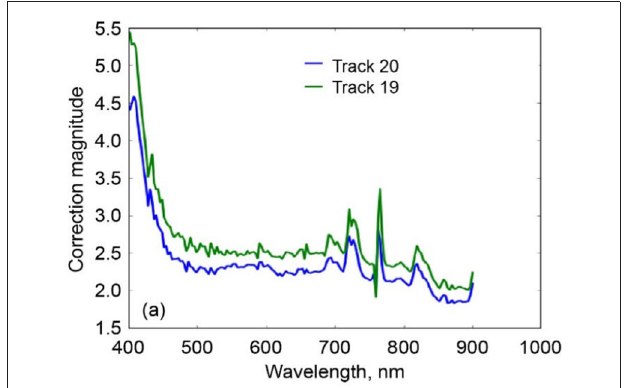
FIGURE 5 | Wavelength-specific correction coefficients derived from comparing to in situ reflectance for two NASA Glenn, second generation Hyperspectral imager (HSI2) tracks (track 19 and 20) (After Figures 4.5, Lekki et al., 2017).